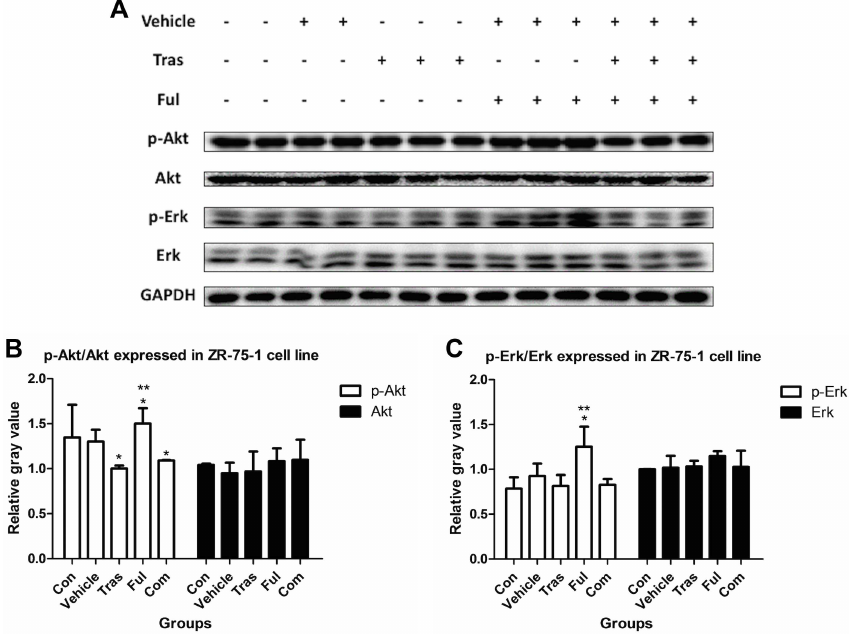
Fig 6. Effects on the levels of the proteins p-Akt and p-Erk extracted from ZR-75-1 cells either untreated or cultured in the presenceof vehicle or trastuzumab at ED 50 or fulvestrant at ED 50 or with a combination of both for 72h. p-Akt and p-Erk proteins from two samplesin the control group and vehicle group and from three samples in each treatment group were detected. It was found that trastuzumab decreased p-Akt levels and that fulvestrant increasedboth, p-Akt and p-Erk levels. In addition,the combination of both drugs significantly reducedlevels of p-Akt and notably inhibited the effect that fulvestrant had on the levels of both proteins. * P < 0.05comparedwith control group. ** P < 0.05comparedwith combination